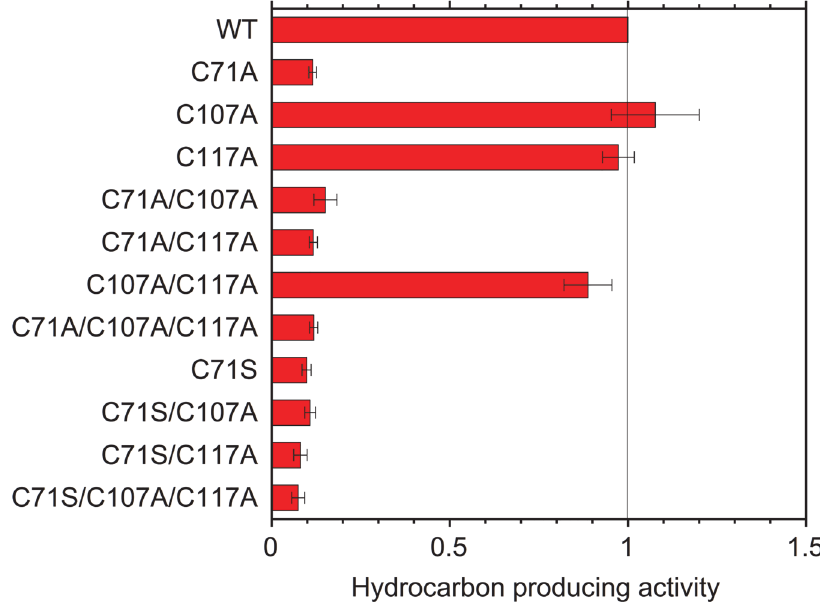
Fig 2. Hydrocarbon producing activities of the wild type and mutant ADs. The activity value presented here is relative to that of the wild type. The data are means ± standard deviations of duplicate or quadruplicate experiments.